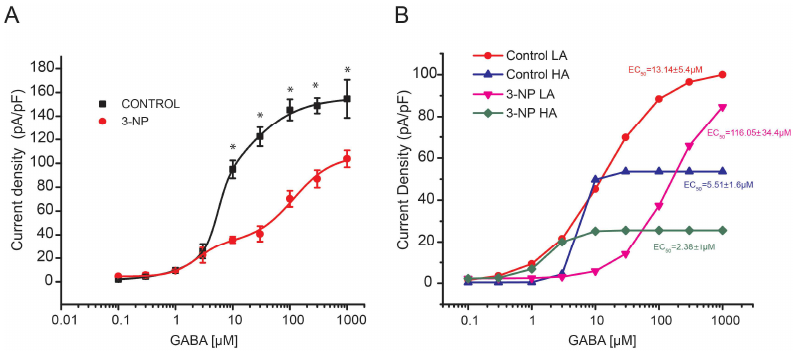
Figure 3. GABA dose-response curves. ( A ) GABA dependent concentrations response to 0.1 µ M ( n = 12), 0.3 µ M ( n = 10), 1 µ M ( n = 10), 3 µ M ( n = 12), 10 µ M ( n = 12), 30 µ M ( n = 12), 100 µ M ( n = 15), 300 µ M ( n = 15) and 1000 µ M ( n = 15) in both experimental groups * p < 0.01. ( B ) Peeling of sigmoidal functions plots to identify 2 different populations in the control group (LA EC 50 = 13.14 ± 5.478, and HA EC 50 = 5.51 ± 1.695, F 7,2 = 1195.24, p = 0.0001, double logistic regression) and in the 3-NP group (LA EC 50 = 116.05 ± 34.4 and HA EC 50 = 2.38 ± 1.09, F 7,2 = 248.69, p = 0.004, double logistic regression).